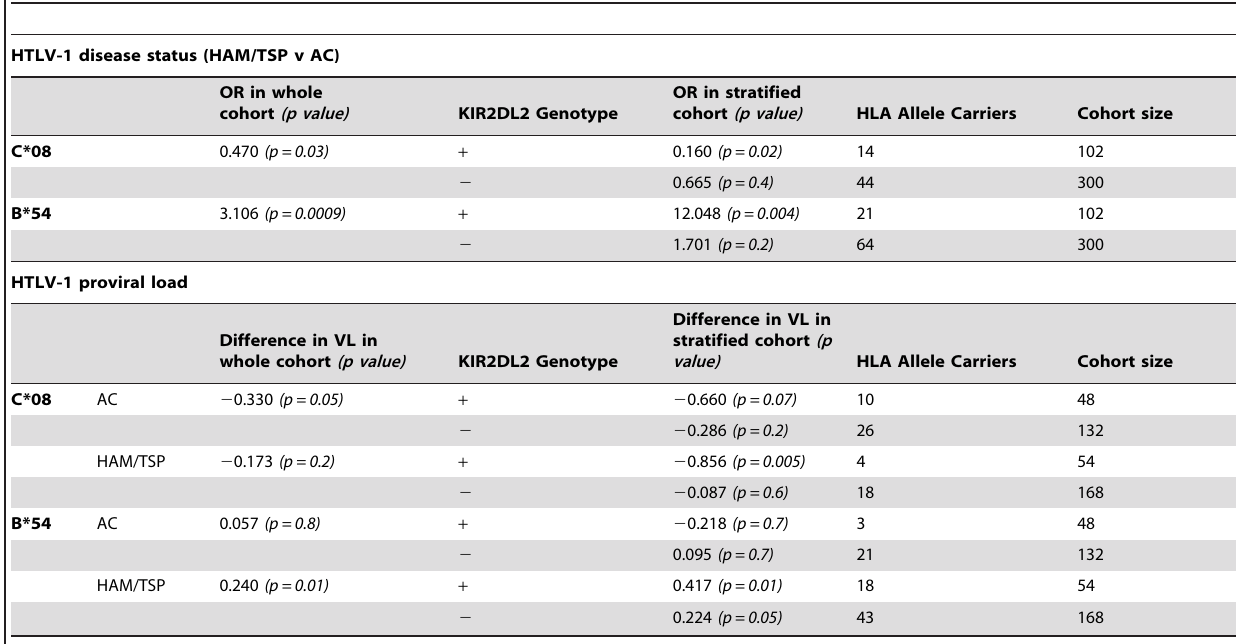
Table 1. KIR2DL2 in HTLV-1 infection: KIR2DL2 enhances the protective effect of C*08 and the detrimental effect of B*54 on HAM/ TSP risk and, independently, on proviral